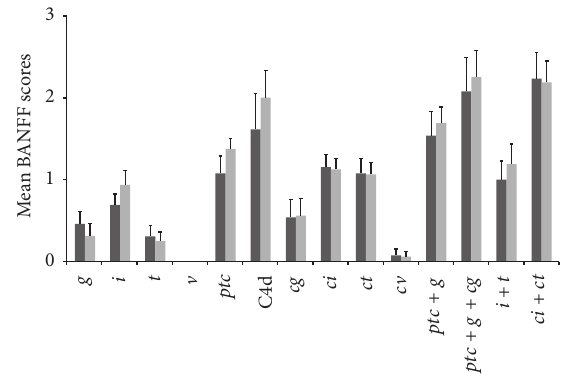
Figure 3: Histological analysis in 30 graft biopsies obtained from 13 recipients displaying early-onset dn DSAs (dark grey bars) and 17 recipients positive for late-onset dn DSAs (light grey bars). The biopsy findings were analyzed both individually ( i, t, ptc, g, ci, ct, cg, cv, v ) and in functional clusters ( ptc + g referring to microcirculation inflammation, ptc + g + cg to microcirculation lesions, i + t to tubulointerstitial inflammation, and ci + ct to tubulointerstitial scarring). Data are presented as the mean ± standard error. For each parameter, no significant difference was observed between the two